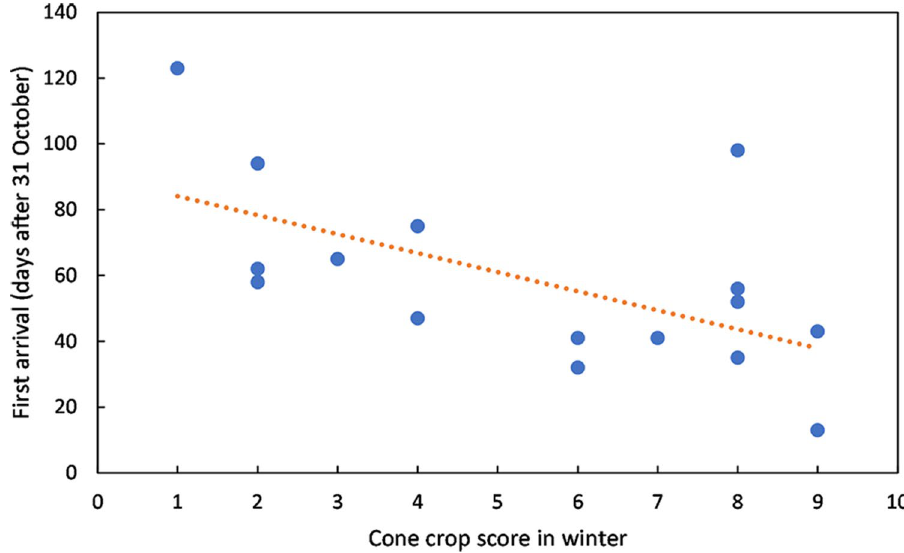
Figure 2. First arrival of siskins. Date of first capture (days after 31 October) in relation to cone crop score that winter. Data for 2005–2020. R 2 = 0.3433.